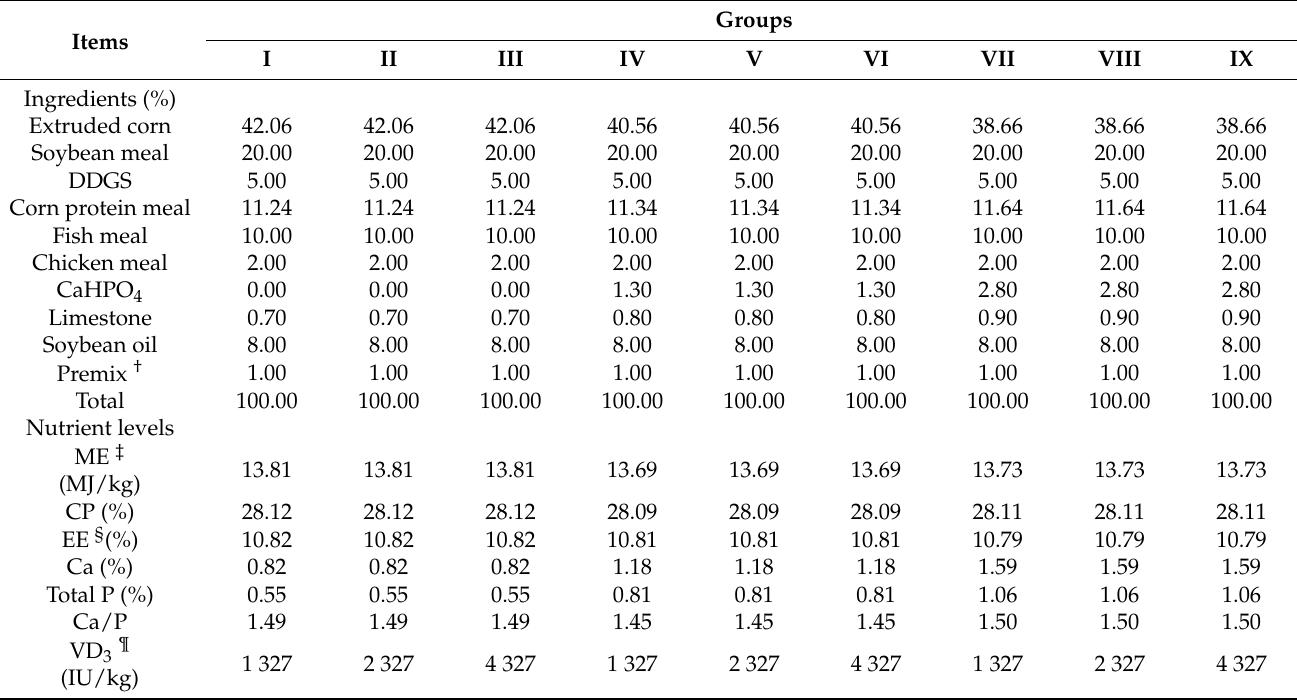
Table 1. Composition and nutrient levels of the experimental diet in growing blue foxes (air-dry